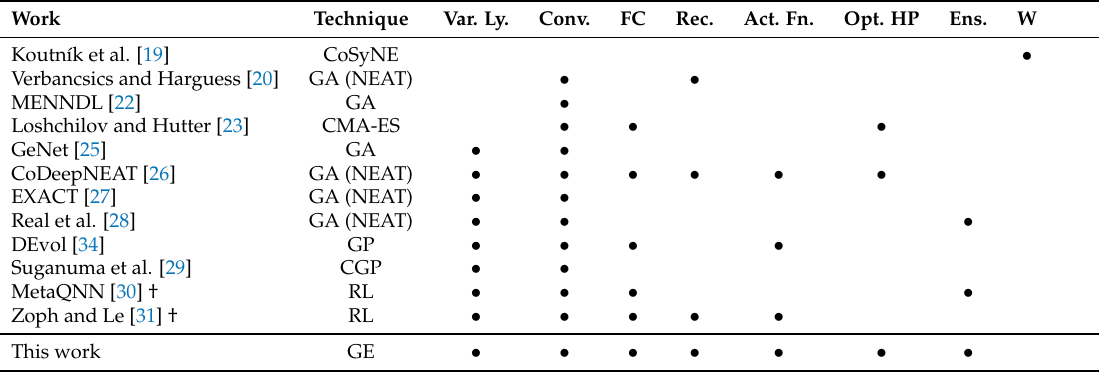
Table 1. Brief comparison of the features of our neuroevolutionary system with related works. Works marked with a dagger (†) do not use evolutionary computation, but rather reinforcement learning. The comparison criteria include whether the proposal supports a variable number of layers (Var. Ly.), and whether it evolves convolutional layers (Conv.), fully-connected layers (FC), recurrent layers (Rec.) or some of their hyper-parameters, activation functions (Act. Fn.), optimization hyperparameters (Opt. HP), ensembles of neural networks (Ens.) or weights (W). CoSyNE: cooperative synapse neuroevolution; NEAT: neuroevolution of augmenting topologies; CMA-ES: covariance